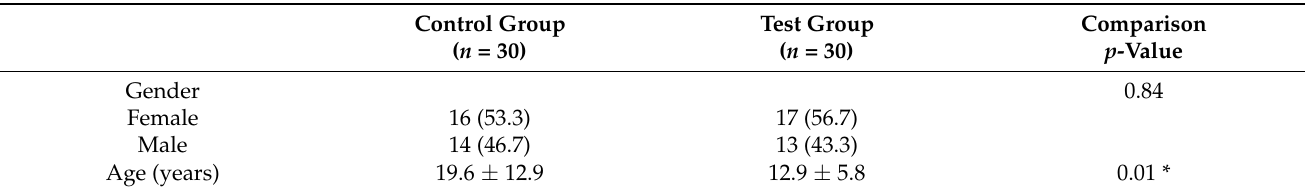
Table 1. Patient baseline characteristics by group ( n = 60). The values given are average ± standard deviation or number (%).